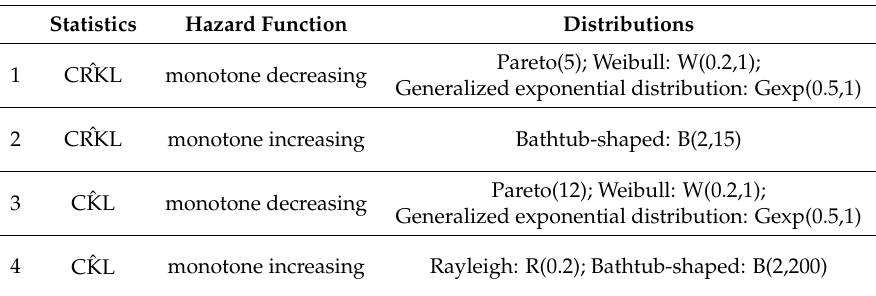
Table 1. Alternative hypotheses for power